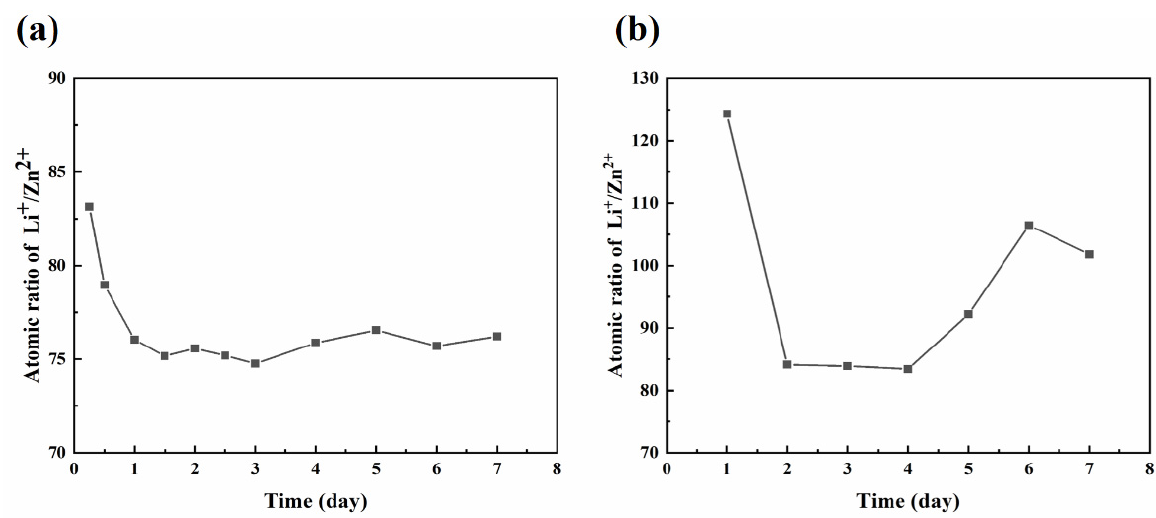
Figure 7. Releasing Li + /Zn 2+ atomic ratio in SGF ( a ) and SIF ( b ) at different times.